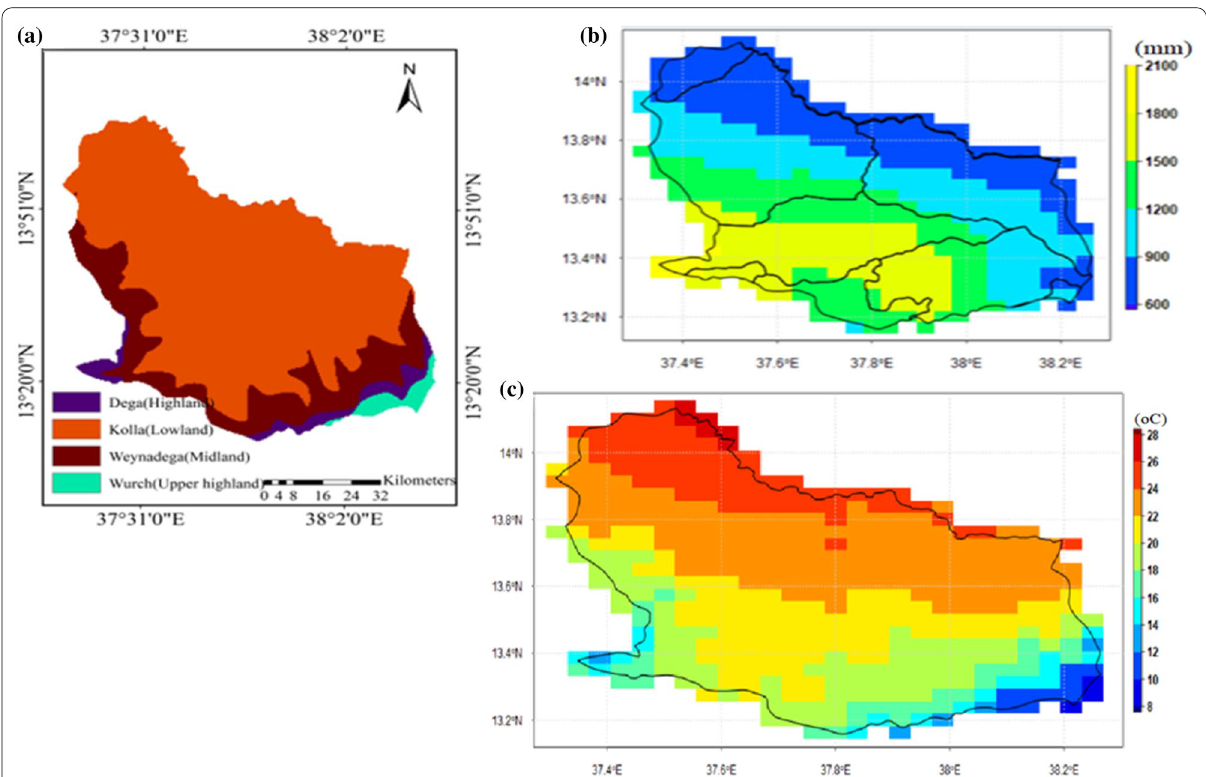
Fig. 4 Agroclimatic Zones a mean annual rainfall, b average temperature and c of Zarima Subbasin